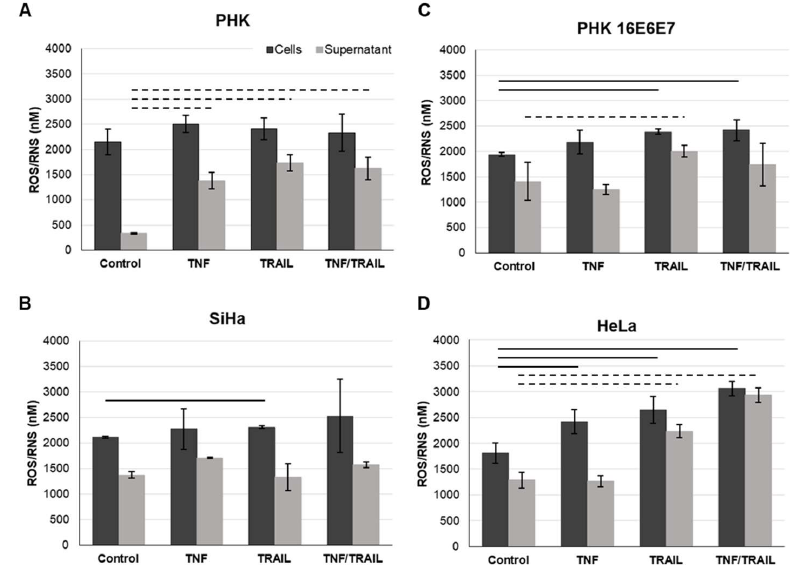
Figure 5. Pro-inflammatory cytokines TNF and TRAIL increase the production and release of reactive oxygen and nitrogen species (ROS/RNS) in cells expressing HPV oncogenes. The levels of ROS and RNS in the absence or presence of pro-inflammatory cytokines alone (2 nM TNF or 50 ng/mL TRAIL) or in combination (2 nM TNF and 50 ng/mL TRAIL) were determined in cultures of PHKs ( A ), PHKs transduced with HPV16 oncogenes ( B ), and in cervical cancer-derived cell lines SiHa (positive for HPV16) ( C ) and HeLa (positive for HPV18) ( D ) using the OxiSelect™ In Vitro ROS/RNS Assay Kit (Cell Biolabs, Inc.), according to the manufacturer’s instructions. The results presented are representative of three independent experiments. Solid lines represent statistical differences between intracellular samples and dashed lines between supernatant samples as determined by Student’s t -test ( p -value ≤ 0.05).